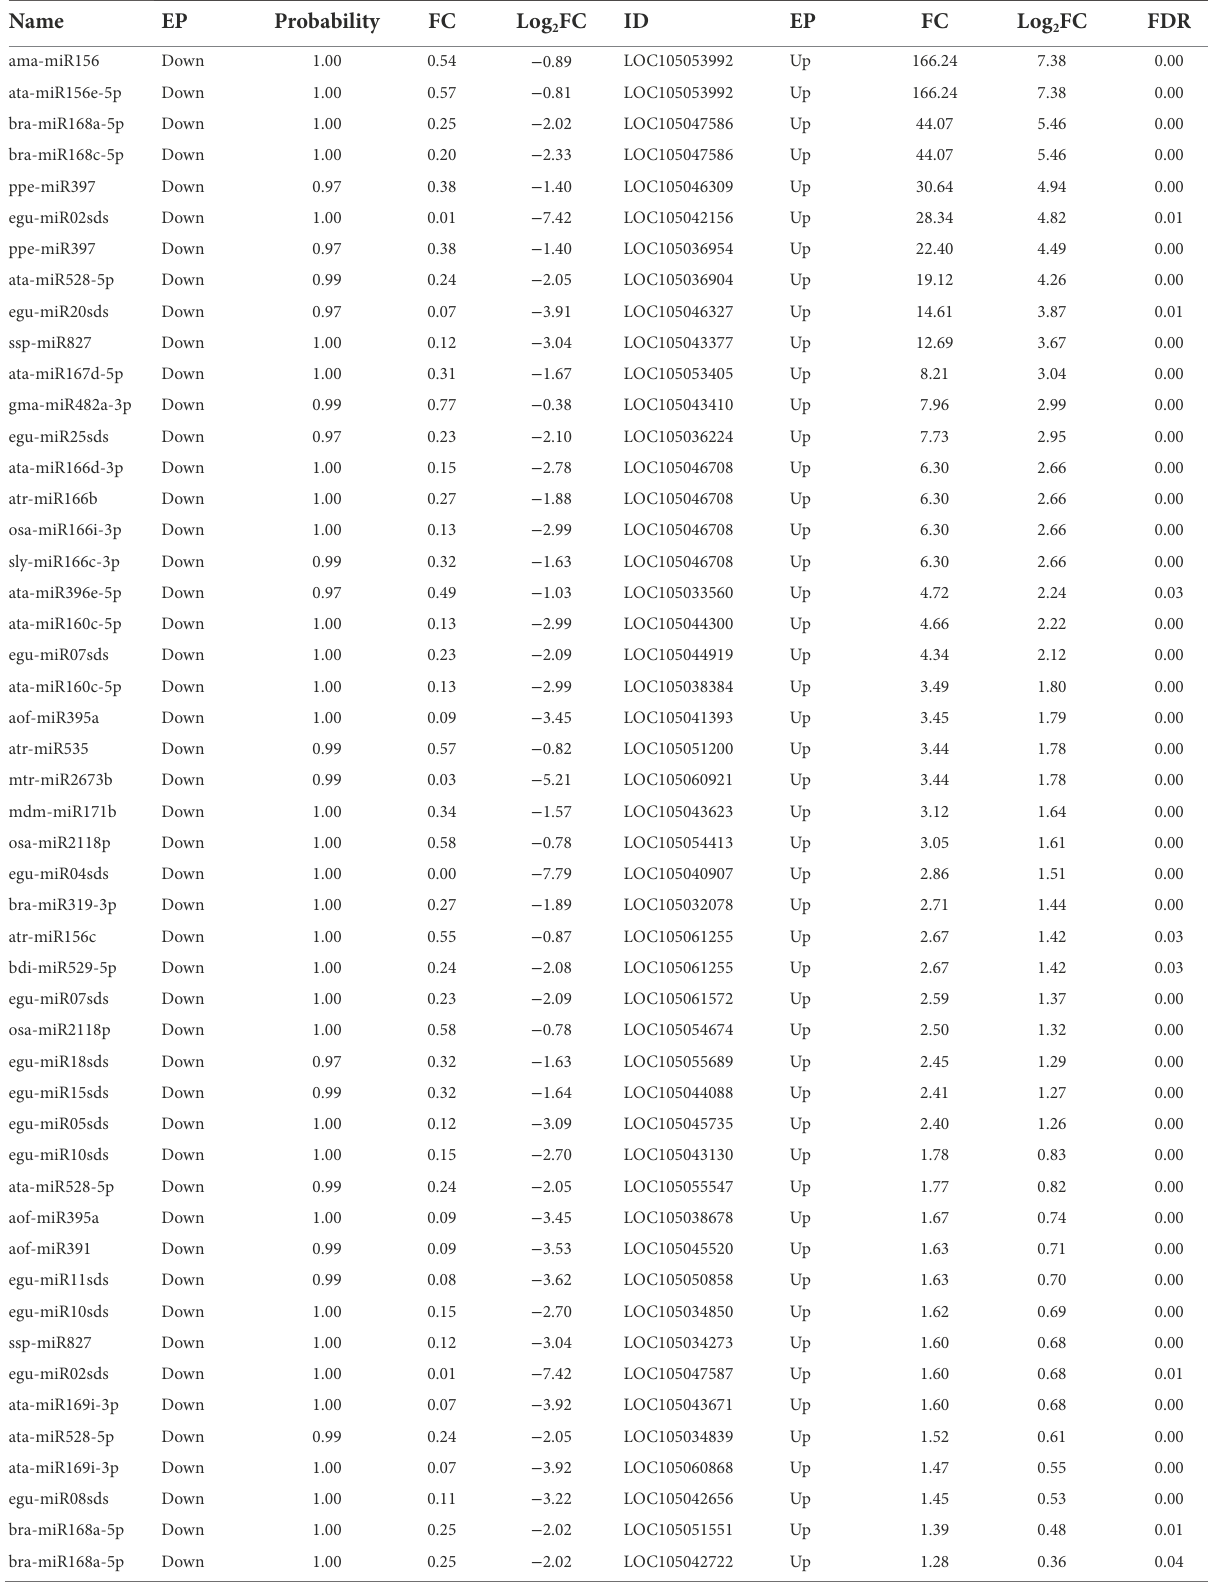
TABLE 4 Profile of differential expressed miRNA and their differential expressed putative target genes from oil palm plants. miRNA Putative target